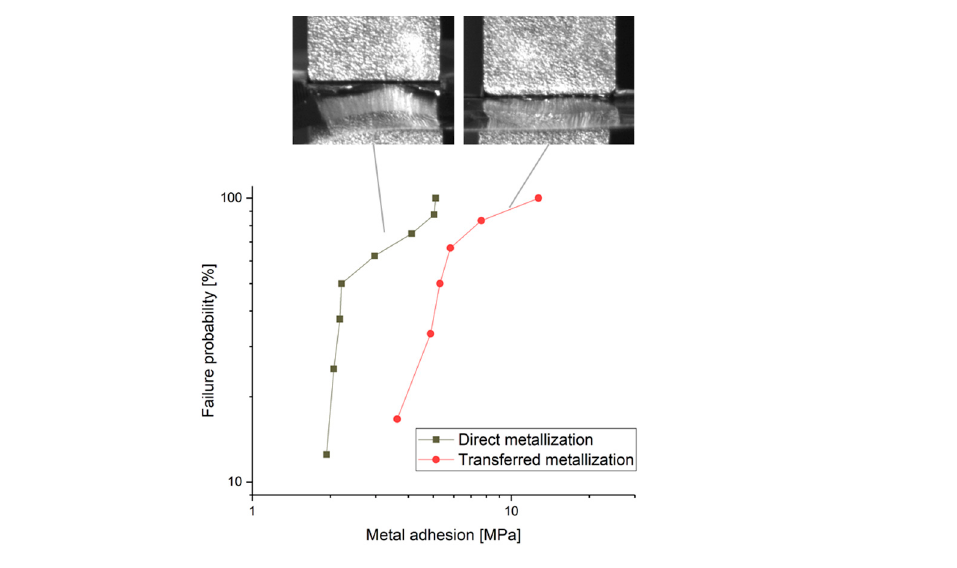
Figure 9. Weibull plot of the tensile strengths for GenesInk on Parylene, applied by direct metallization and by the transfer process, respectively. The inset shows photos captured by a high-speed camera during the tensile test at the moment before rupture. Note that the upper stud is mirrored in the metallization of the sample and the Parylene foil.